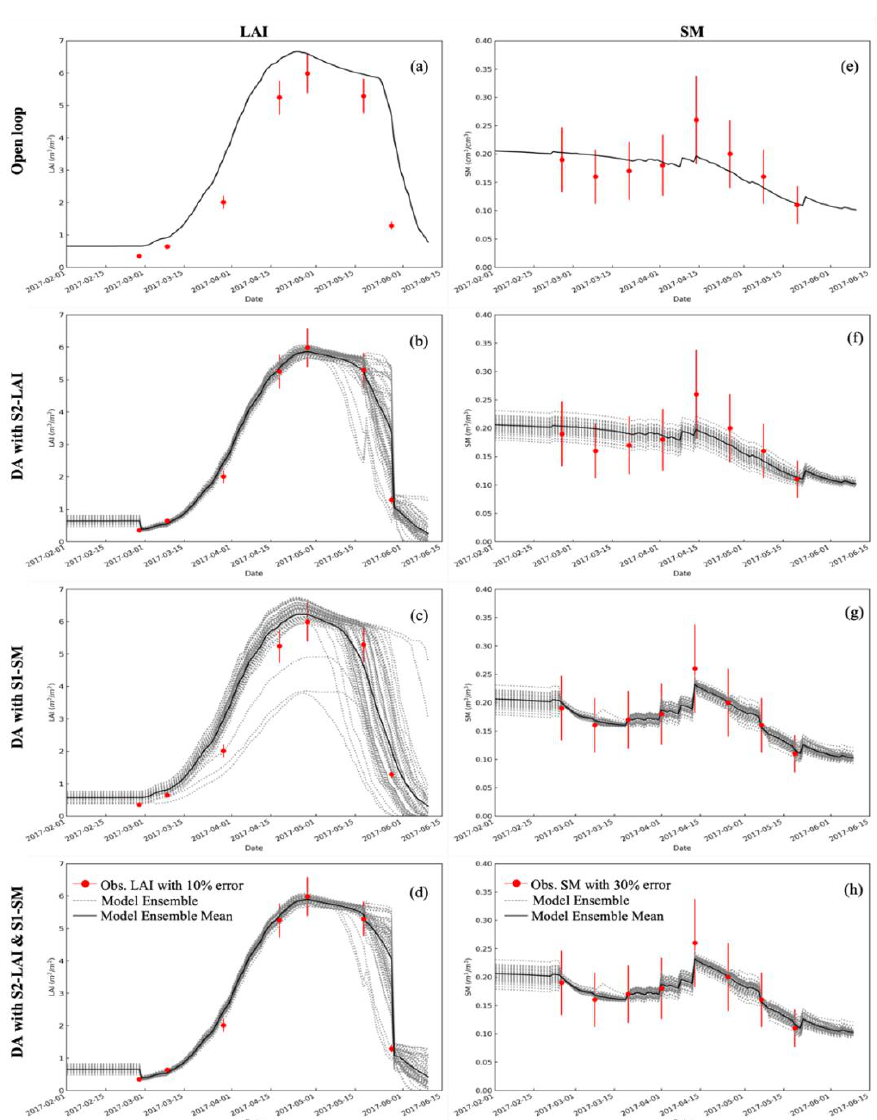
Figure 5. The LAI and SM simulations of the Word Food Studies (WOFOST) with open-loop ( a , e ), assimilation of S2-LAI ( b , f ) and S1-SM ( c , g ) respectively, and joint assimilation of S2-LAI and S1-SM ( d,h ) at the Raoyang site in 2017.